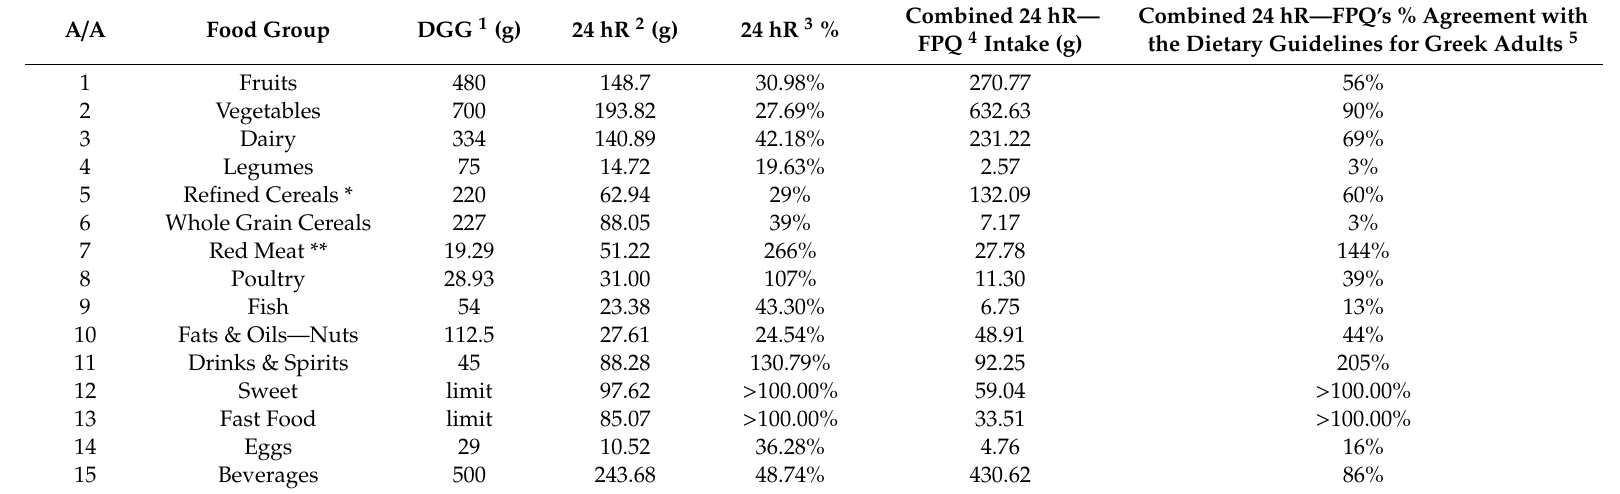
Table 6. Level of agreement between the Dietary Guidelines for Greek Adults and Greece’s population’s consumption per food